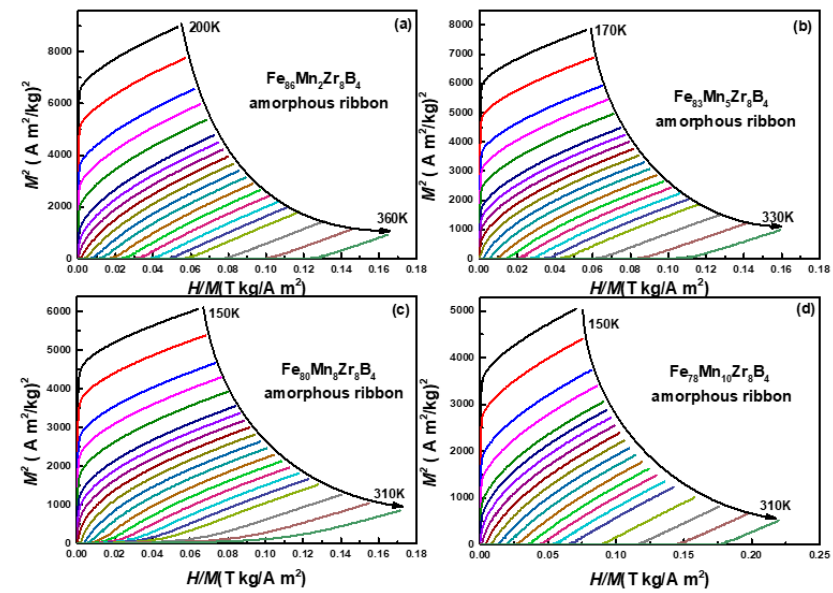
Figure 6. The Arrott plots of the Fe 88 − x Zr 8 B 4 Mn x (x = 2, 5, 8 and 10) glassy samples. ( a ) for Fe 86 Zr 8 B 4 Mn 2 , ( b ) for Fe 83 Zr 8 B 4 Mn 5 , ( c ) for Fe 80 Zr 8 B 4 Mn 8 and ( d ) for Fe 78 Zr 8 B 4 Mn 10